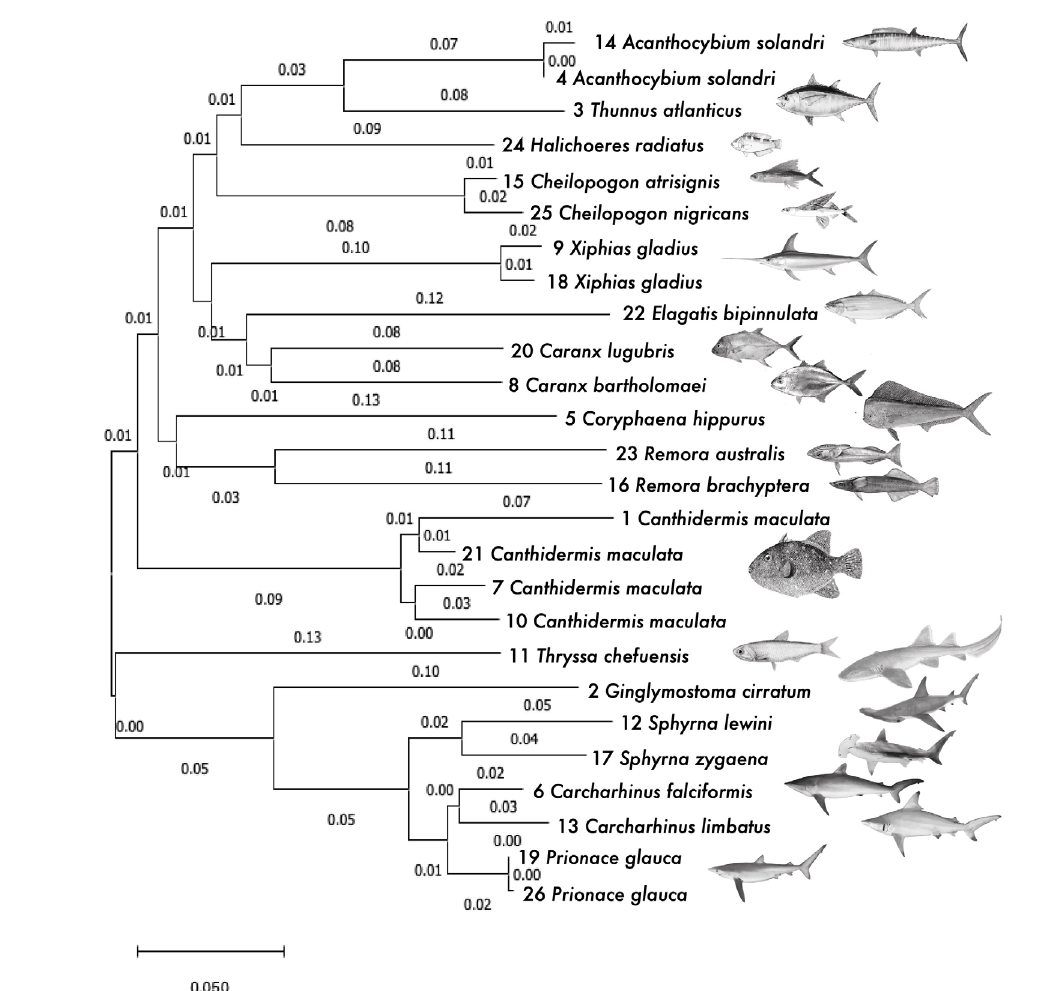
Figure 2 – Neighbor-Joining Tree of the Saint Peter and Saint Paul Archipelago surveyed fish species labeled with substitutions per